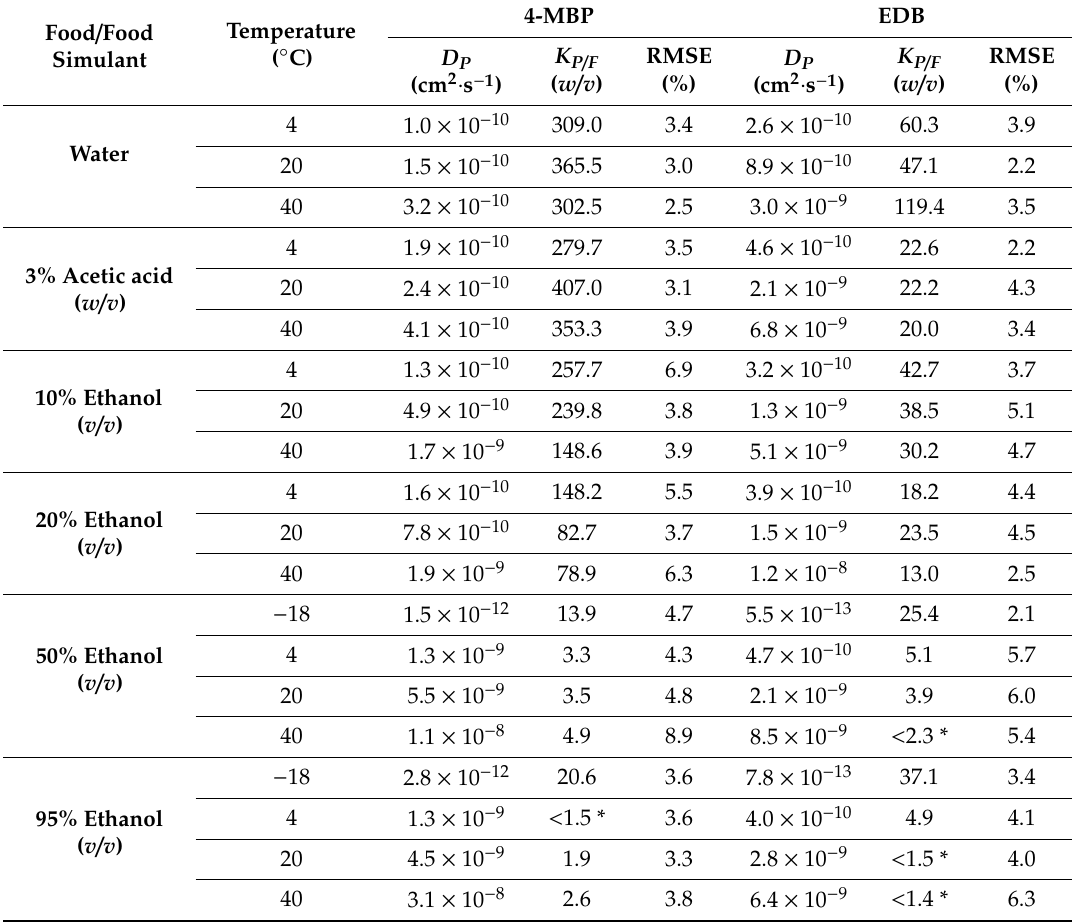
Table 1. Coe ffi cients of di ff usion ( D P ), partition ( K P / F ) and Root-Mean-Square Error (RMSE) of